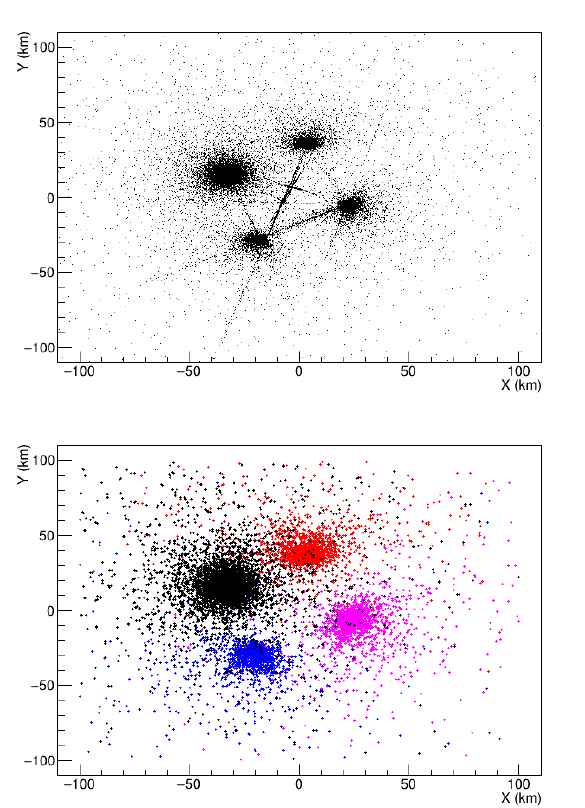
Figure 1. Distribution of shower cores in the burnt dataset before and after the laser cleaning process in the top and bottom panel, respectively. Apparent lines in the upper panel correspond to the misreconstructed laser events, and colours in the bottom panel represent FD sites that detected individual showers.